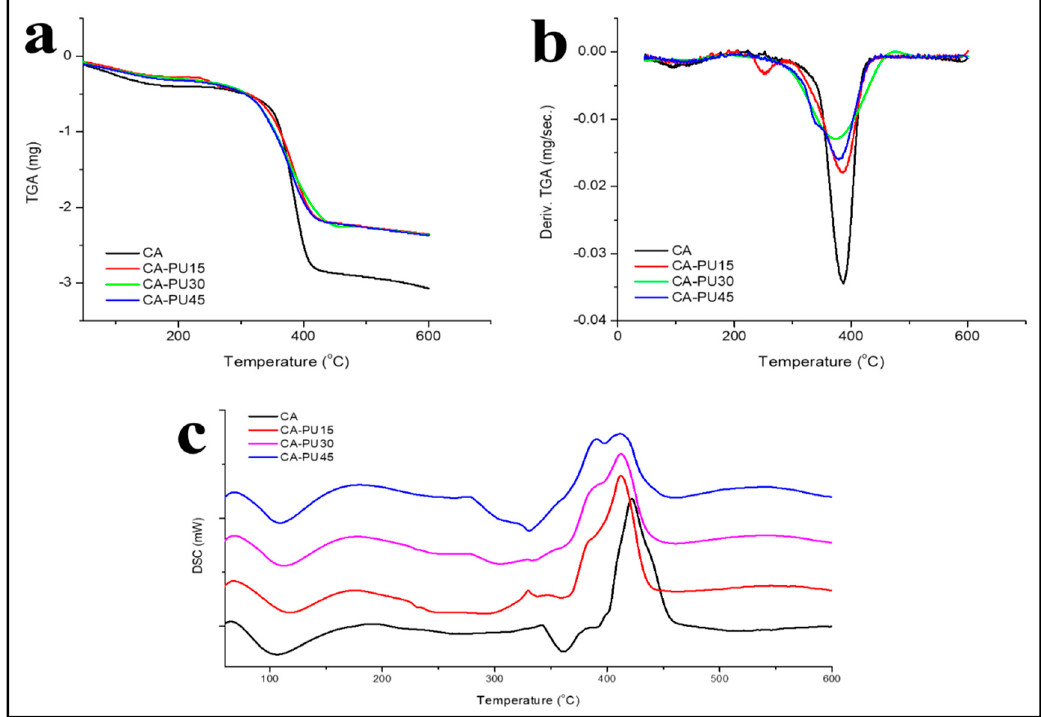
Figure 6. ( a ) TGA; ( b ) DTGA; and ( c ) DSC thermogram of CA–PU15, CA–PU30, CA–PU45, and CA.